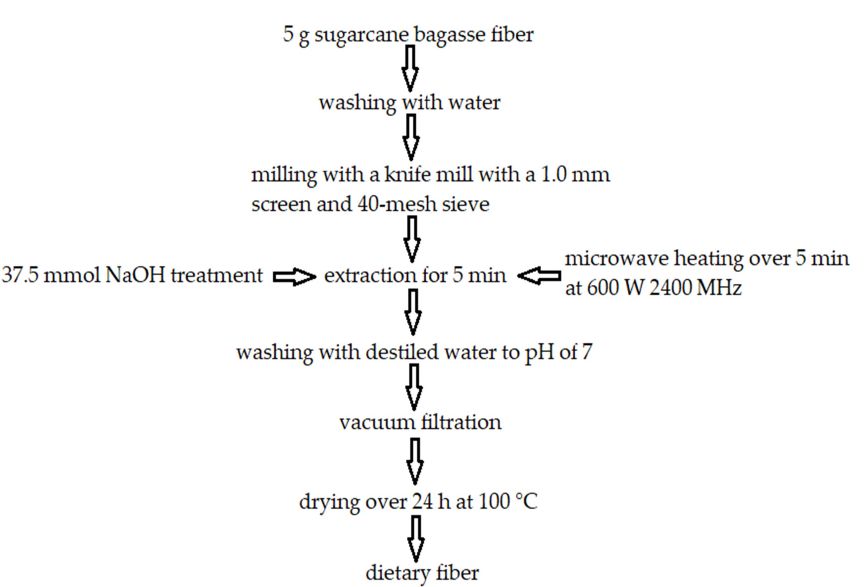
Figure 3. Production of dietary fiber from raw sugarcane bagasse fibers. Own figure based on Ref. [119]. 2022, Gil-López et al.